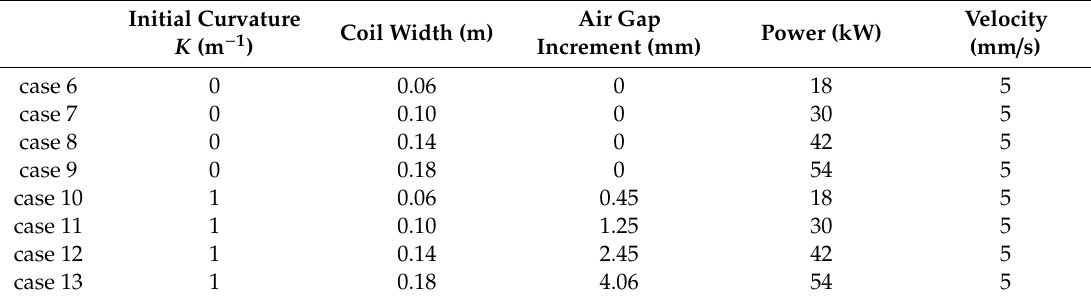
Figure 14. Heat generation in section S 2 –S 2 . We performed the eight heat source models on the heat transfer and mechanical analysis, and the plastic strain distribution and displacement were calculated. Figure 15 shows the plastic strain on the bottom surface (without the inductor side) of the plate along the section S B – S B , which is vertical to the heating line, and the thickness was 20 mm. The strain was divided into the in-plane strain and out-of-plane strain, according to Equations (12) and (13). Strain components in both the X and Y directions are shown. A greater strain can be obtained in a single line process with a wider heat source. Considering the relative variation of the plastic strain when the curvature increases from 0 to 1, the maximum of the relative variation with different coil widths are listed in Table 5. Similar to the pattern of heat generation, when the coil width is less than 100 mm, it can be considered that the effect of plate curvature on heat source distribution and strain distribution is not obvious, as the relative variation is mainly below 15%. When the coil width is over 100 mm, the plastic strain was obviously reduced while the curvature increased. Curvature has a larger effect on strain in the Y direction than the X direction. The same pattern can be concluded from different plate thicknesses.